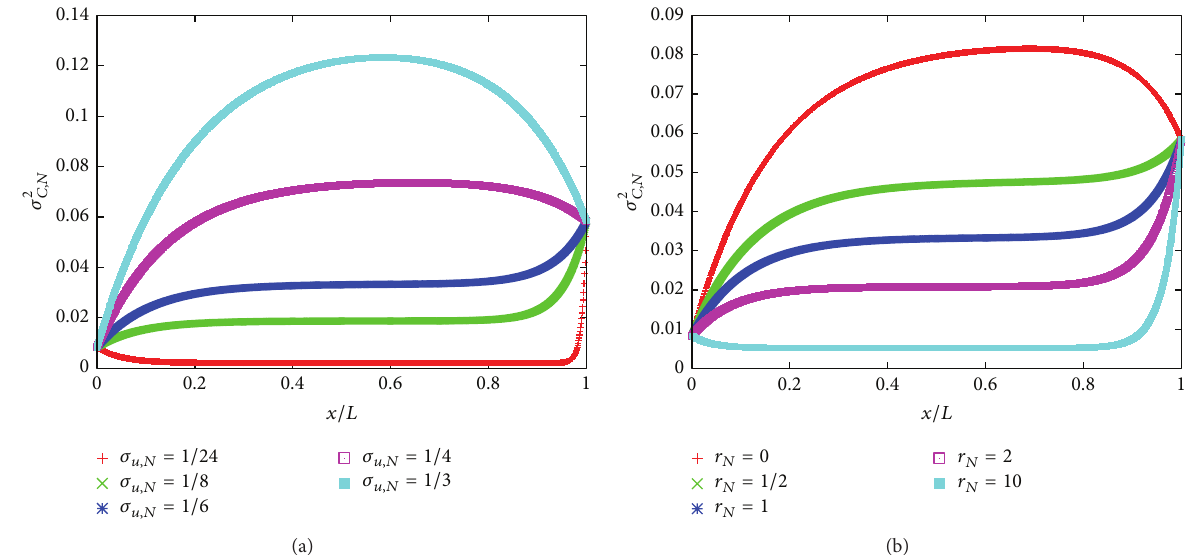
Figure 4: (a) Reference nondimensional solution with sensitivity analysis on the nondimensional standard deviation of velocity, which is is 0.002083, 0.01875, 1/30, 0.075, and 4/30, respectively. (b) Reference alternatively equal to 1/24 (+), 1/8 ( × ), 1/6 ( ∗ ), 1/4 ( ◻ ), and 1/3 ( ◼ )— 𝜎 2 𝐶, eq ,𝑁 nondimensional solution with sensitivity analysis on the nondimensional reaction rate, which is alternatively equal to 0 (+), 1/2 ( × ), 1 ( ∗ ), 2 is 1/12, 0.04762, 1/30, 0.02083, and 0.005208, respectively. ( ◻ ), or 10 ( ◼ )— 𝜎 2 𝐶, eq ,𝑁